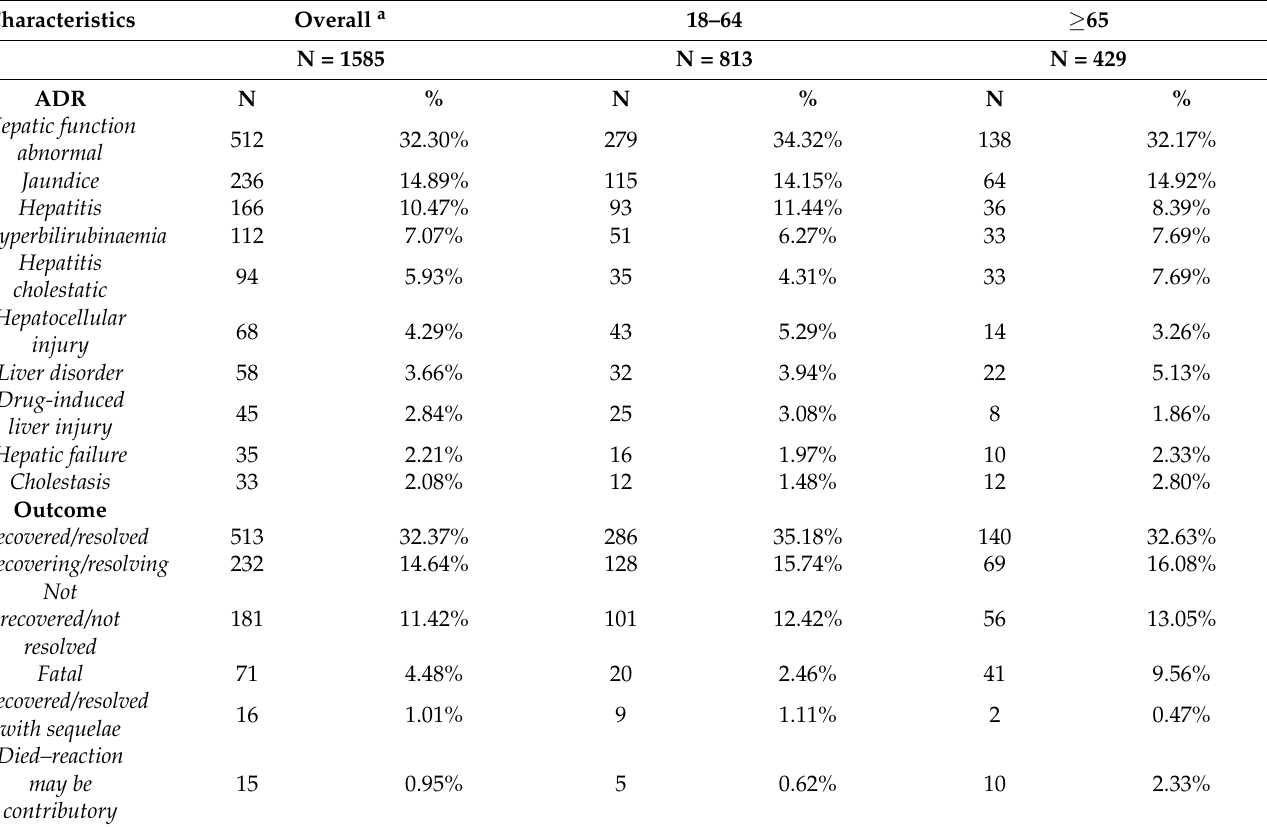
Table 2. Most frequent adverse drug reactions and outcomes of adverse drug reactions in the Hepatobiliary System Organ